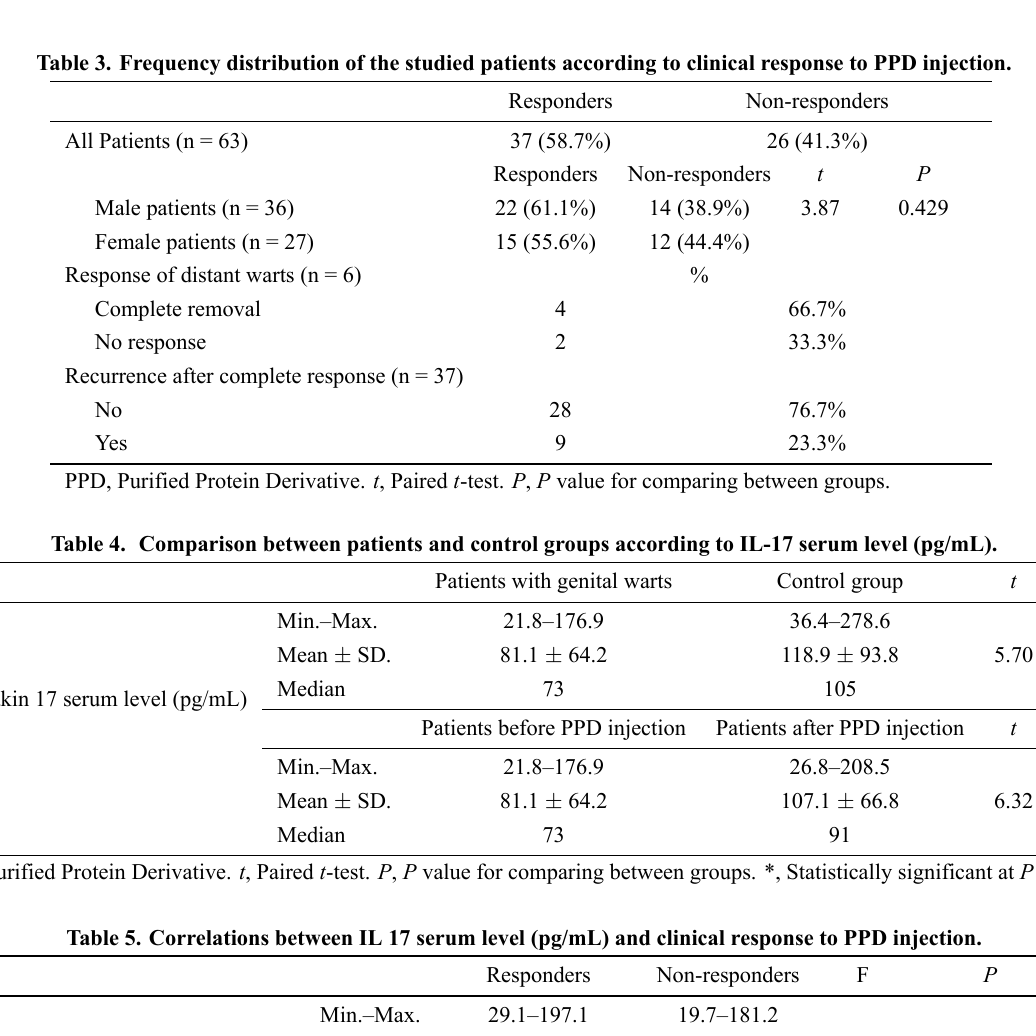
Interleukin 17 serum level (pg/mL)